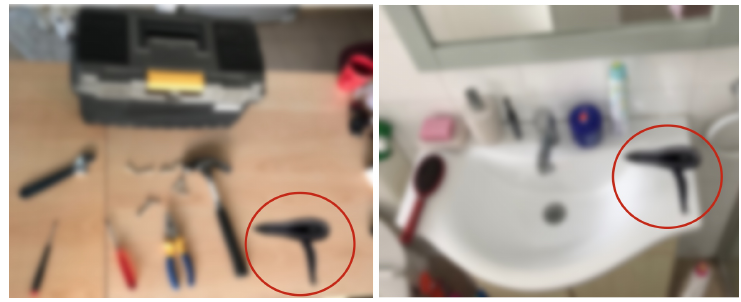
Figure 1. The powerful effects of